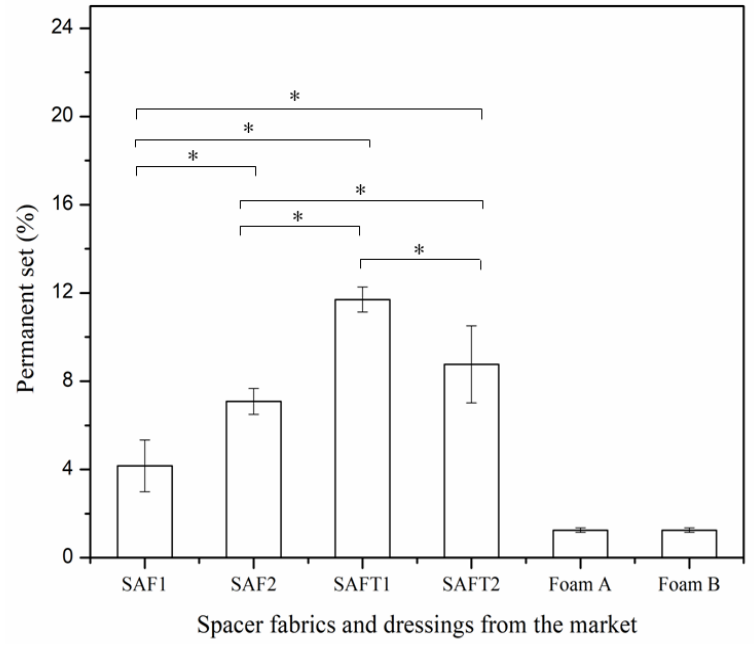
Figure 13. Permanent set of spacer fabrics and foam dressings from the market. * p < 0.05. .